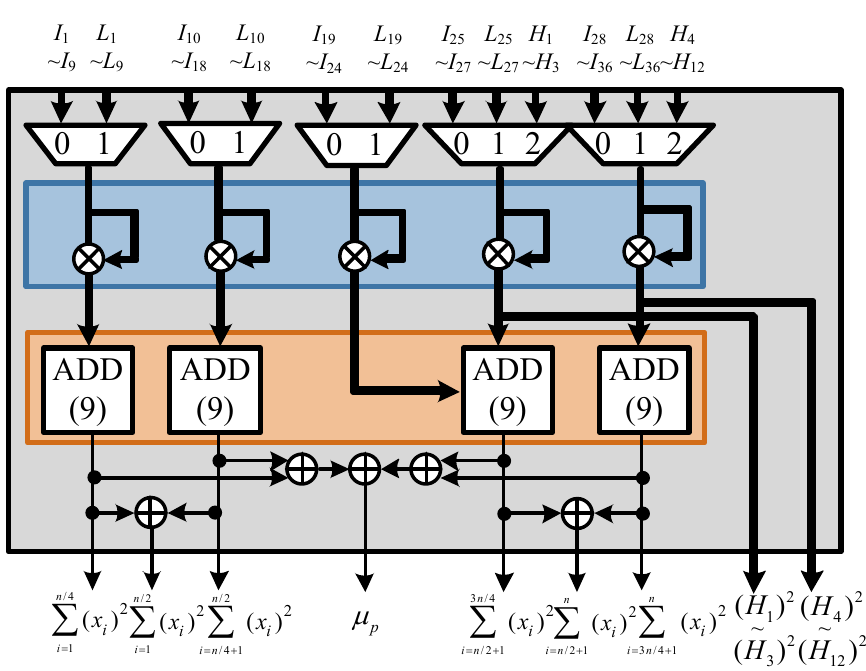
Figure 16. Hardware architecture of square-sum